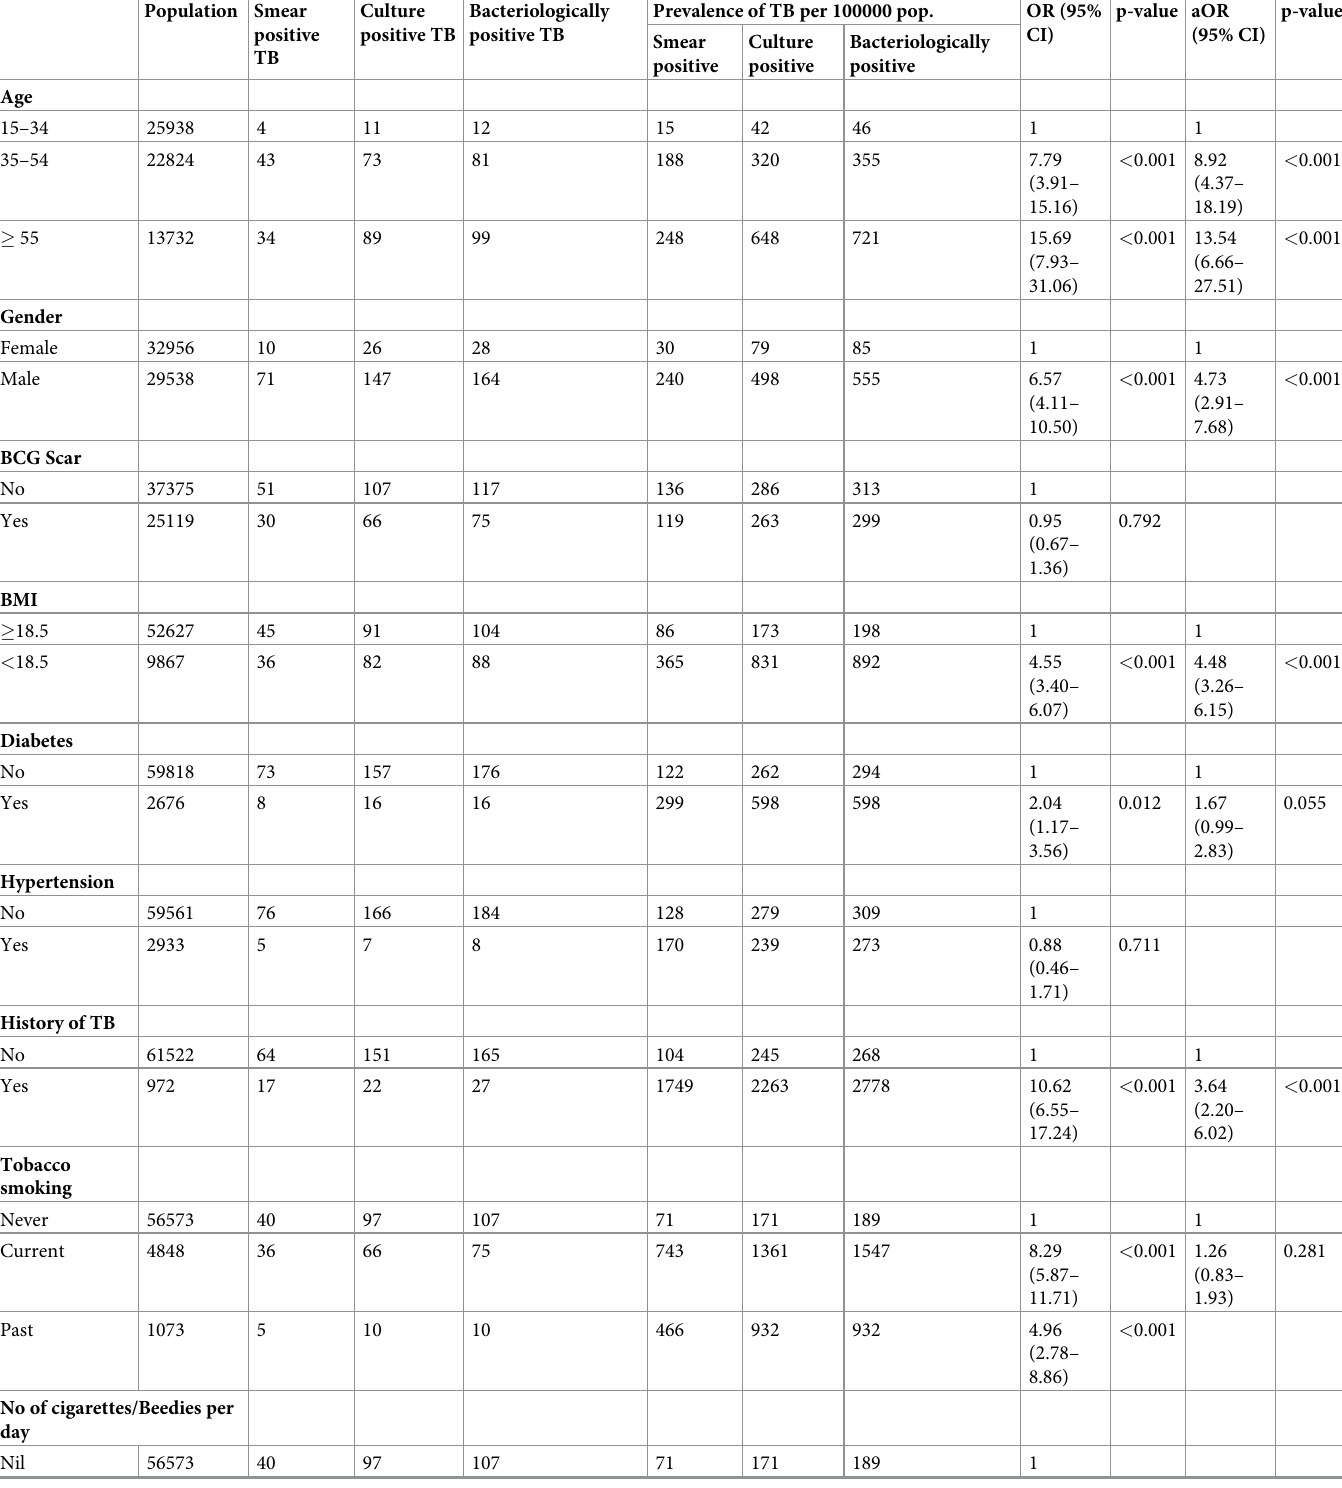
Table 2. Estimated prevalence of TB and its associated risk